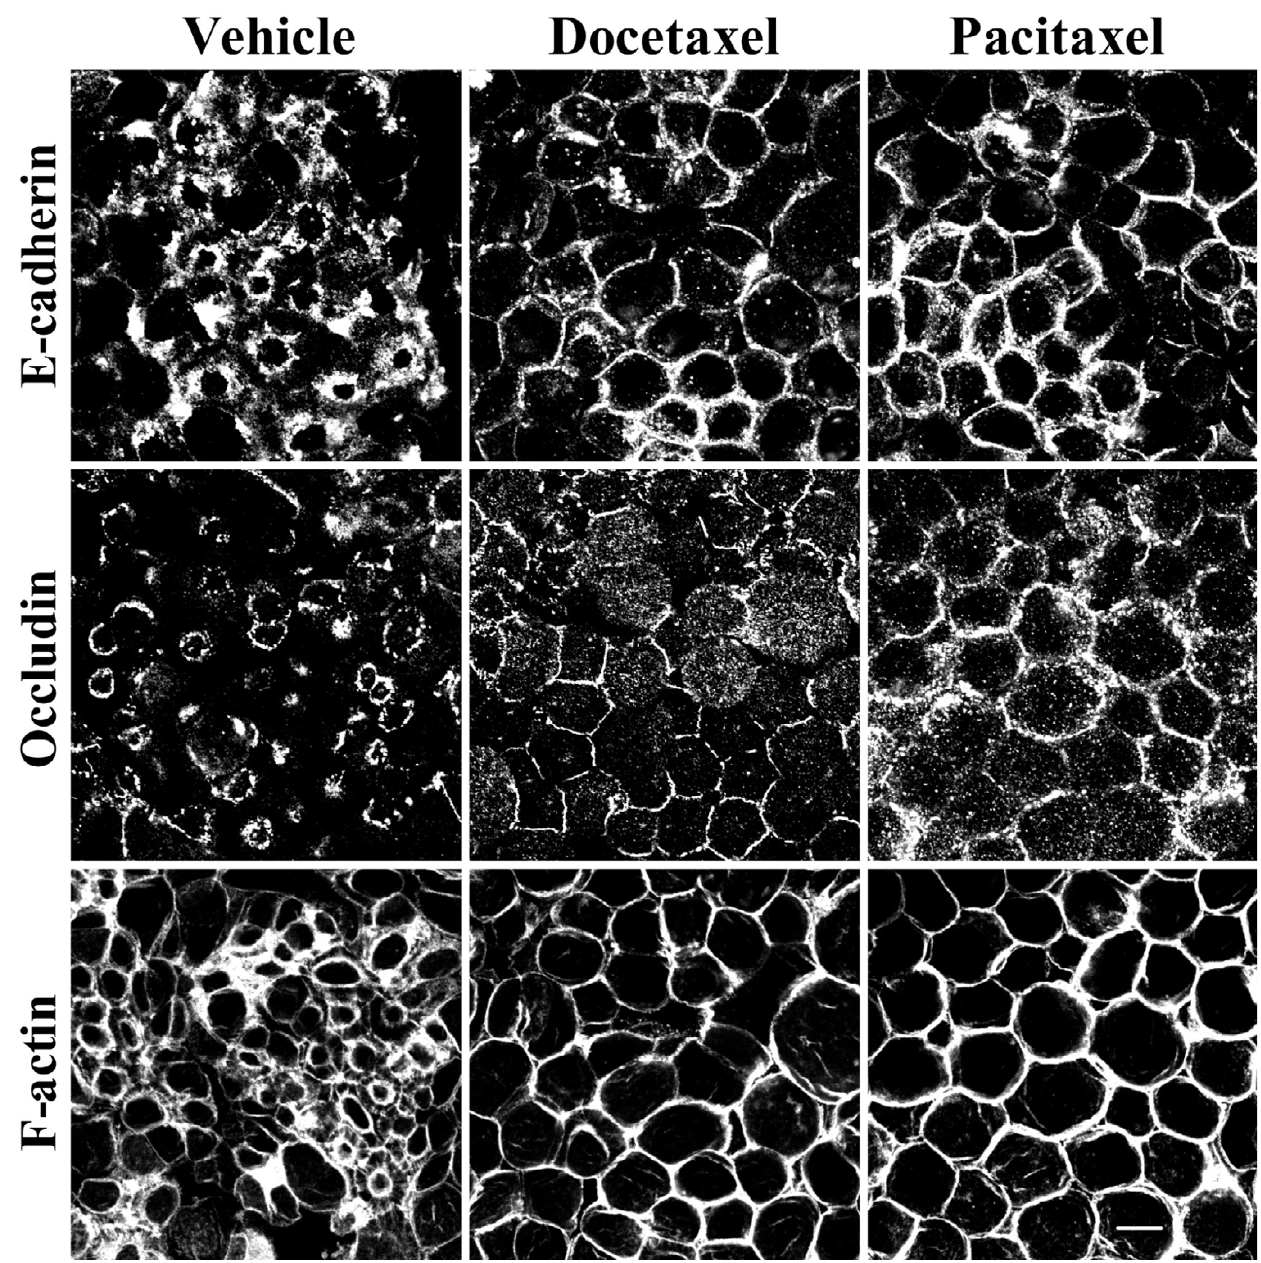
enin, occludin and ZO-1 in subapical ring-like structures (Figure 1). Treatment of SK-CO-15 cells with nocodazole (30 µ M), which effectively eliminated the majority of api-